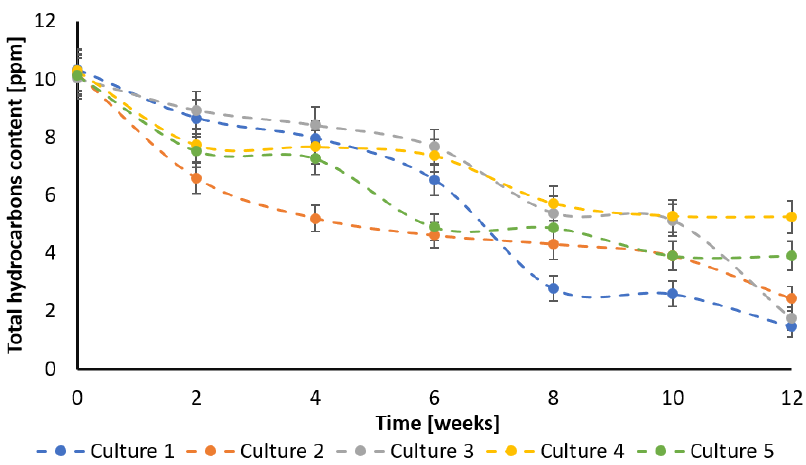
Figure 1. Changes in creosote concentration in different